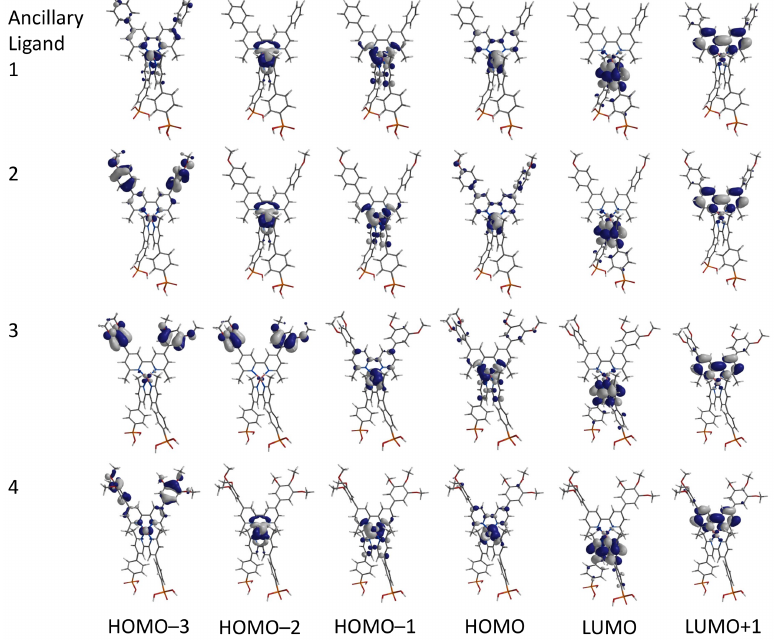
Figure 10. Characteristics of the MOs from HOMO − 3 to LUMO+1 of [Cu( 5 )( 1 )] + (top row), [Cu( 5 )( 2 )] + , [Cu( 5 )( 3 )] + , and [Cu( 5 )( 4 )] + (bottom row). The orientation of the complex is the same in each figure,